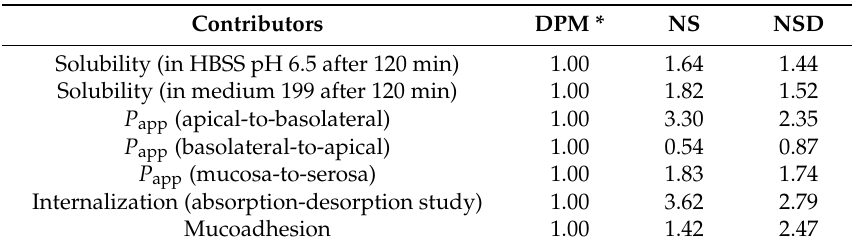
Table 5. Comparison of performance of DPM, NS and NSD w.r.t. various contributors studied in the present work.